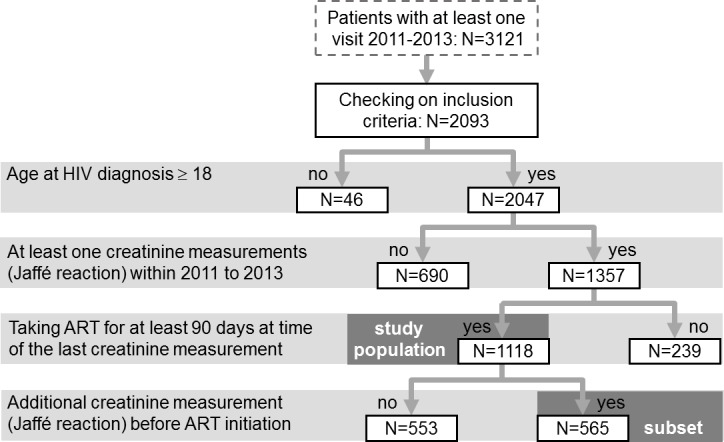
Study population flowchart.